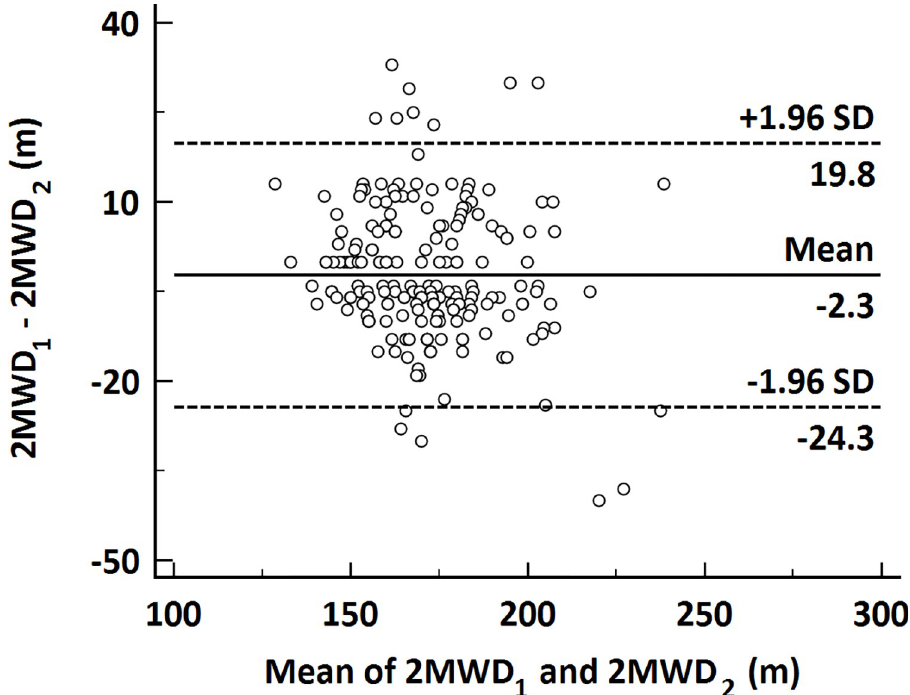
Fig 1. Bland-Altman plot of the results for performance in the first and second 2MWTs.